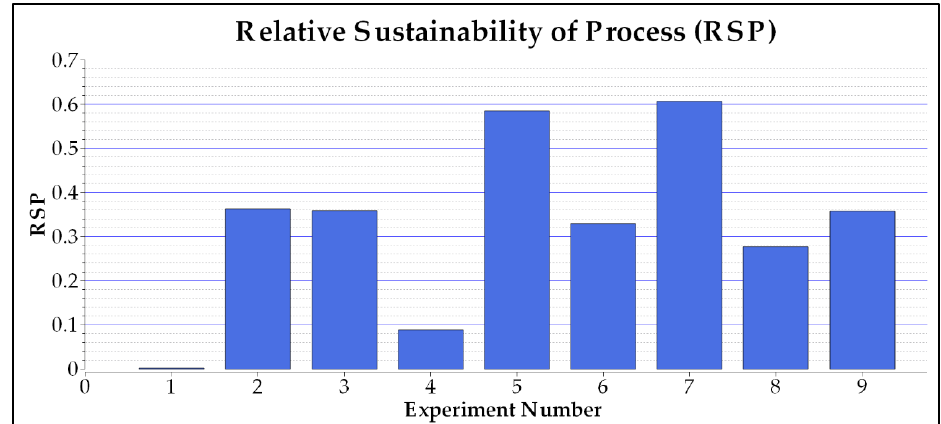
Figure 5. RSP of the alternatives in Shokrani et al. [25].